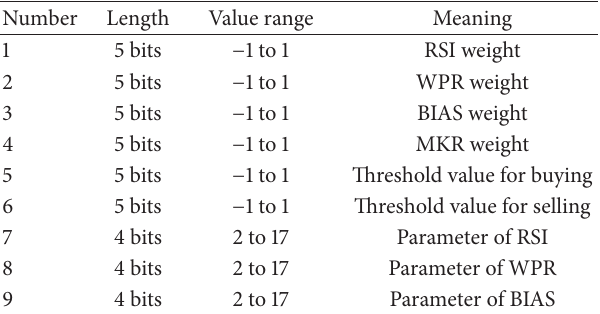
Table 8: Chromosome design of the GA model. Table 9: Training and testing